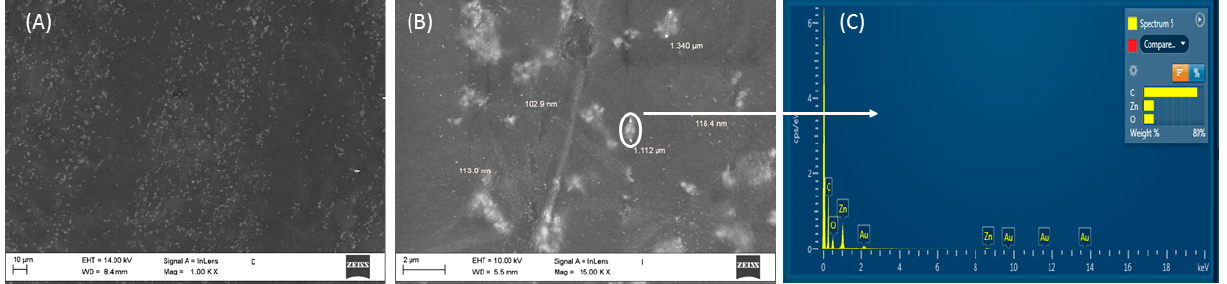
Figure 5. SEM images at different magnification of Azo-LC-PMP-Z6% ( A , B ) and an example of qualitative EDX analysis ( C ) carried out on the sample in correspondence of the aggregate indicated in B.